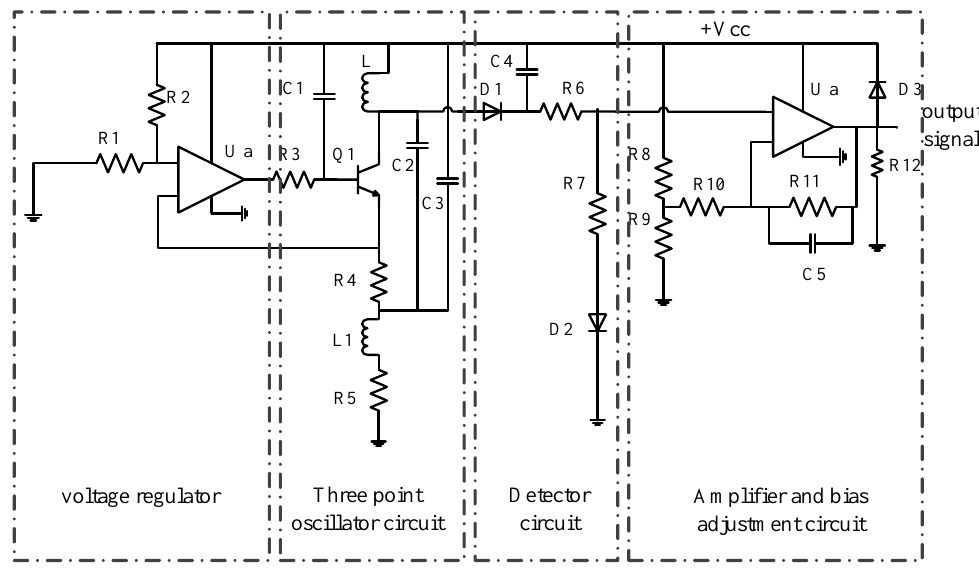
Figure 8. Block diagram of the experimental set-up for CECA sensor measurements.